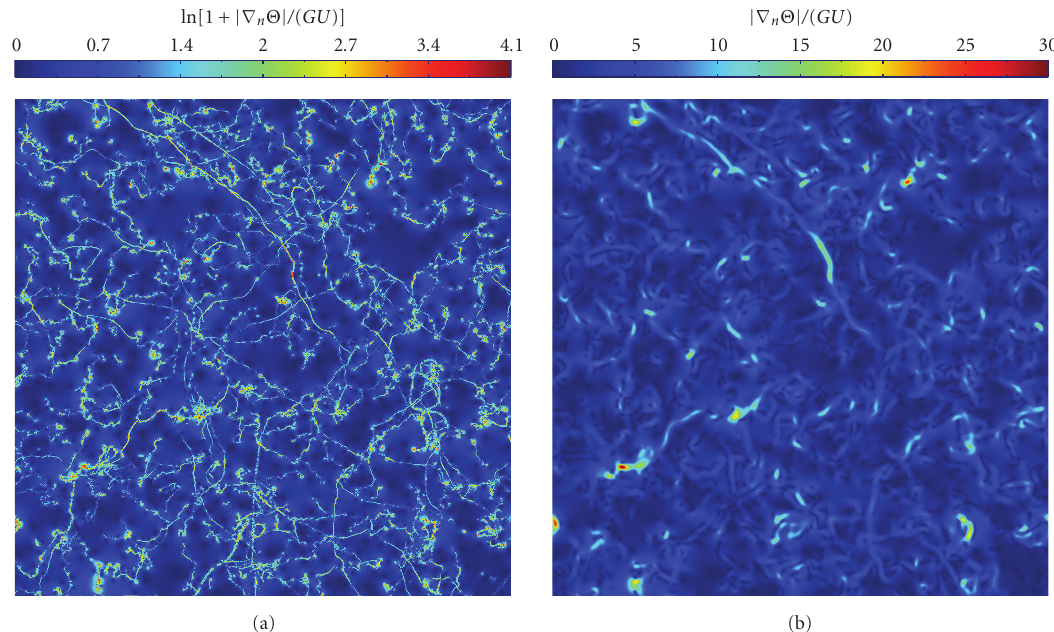
Figure 15: Normalized gradient magnitude of the string-induced temperature anisotropies shown in Figure 13(a). A logarithmic scale has been used to enhance the contrast by preventing the bright spots from saturating the color scale. The right panel is the gradient magnitude obtained after convolution by a Planck-like Gaussian beam of resolution 5 (cid:9) . Notice that the color scale is back to linear, most of the bright spots being now smoothed by the beam.